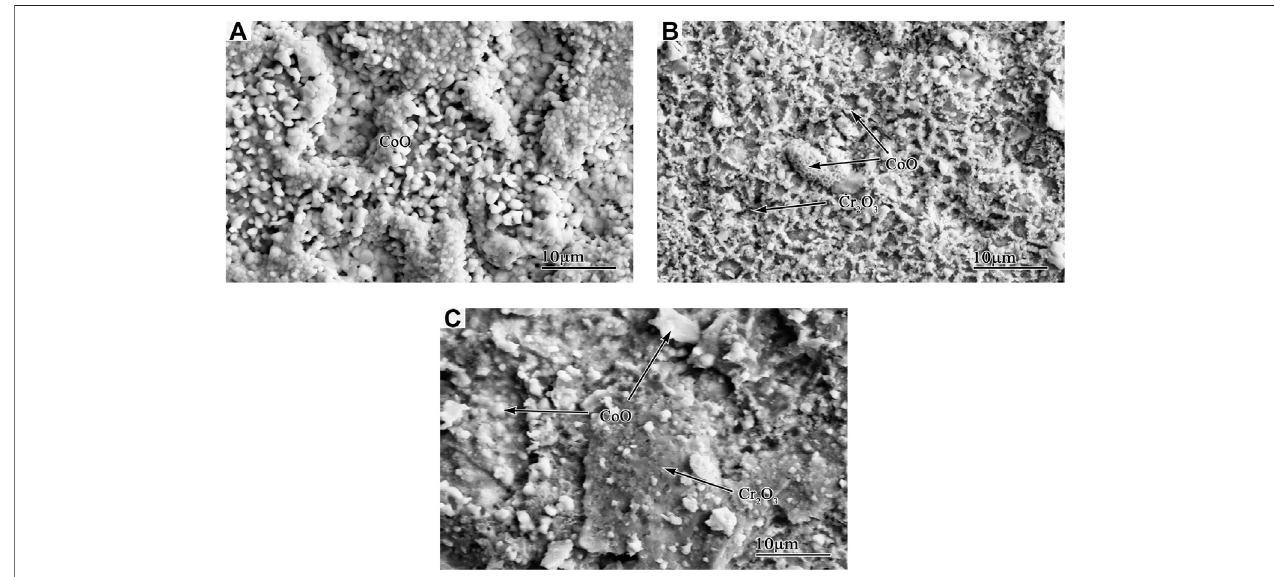
FIGURE 6 | Surface micrographs of Co-20Re-25Cr-3Si alloys oxidized under 0.1 MPa laboratory air for 24 h: (A) 1,000 ° C; (B) 1,100 ° C; (C) 1,200 ° C.